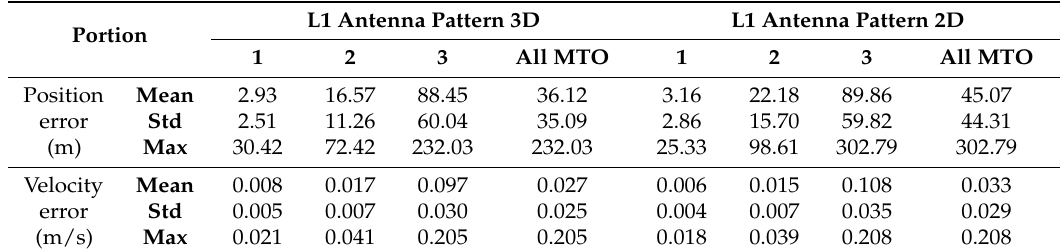
Table 5. Statistics of the range-based orbital filter estimation error.